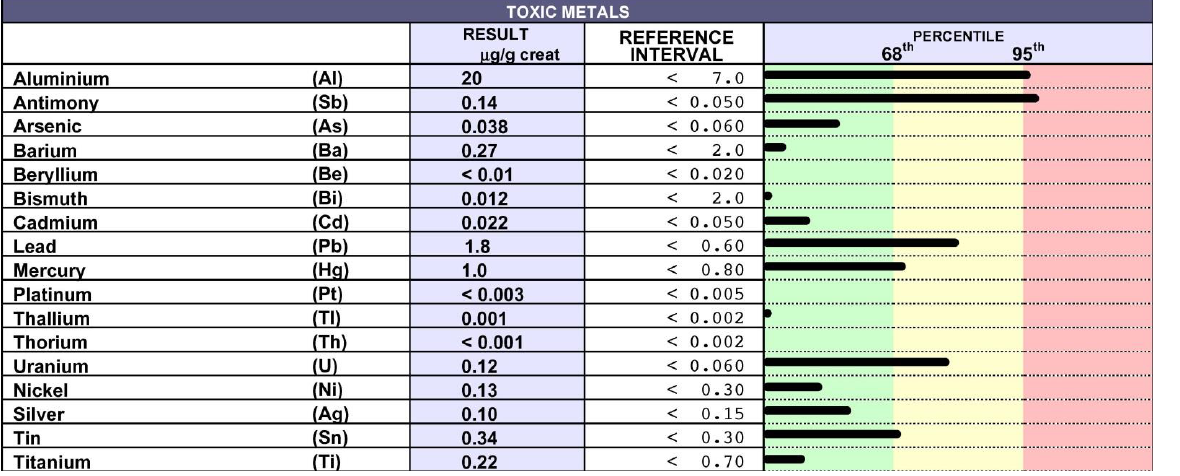
Figure 2. Detection of TMs in the hair of EM: EM did not give consent to the chelation therapy; thus, the presence of TM was detected in her hair using inductively coupled plasma mass spectrometry. Very high/high levels of Al, Sb, Pb, U and, to a lesser extent, Sn and Hg were detected.